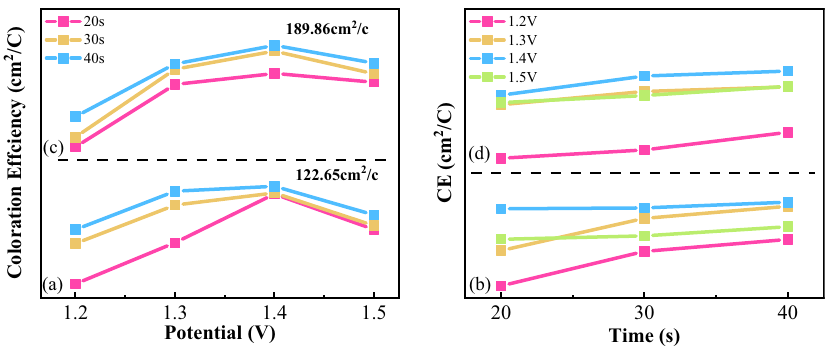
Figure 9: Coloring e ffi ciency of ( a ) PEDOT:PSS fi lms deposited at di ff erent voltages for a de fi nite time, ( b ) PEDOT:PSS fi lms deposited at a de fi nite voltage for di ff erent times, ( c ) PEDOT:PSS/EMI - TFSI fi lms deposited at di ff erent voltages for a de fi nite time, and ( d ) PEDOT:PSS/EMI - TFSI fi lms deposited at a de fi nite voltage for di ff erent